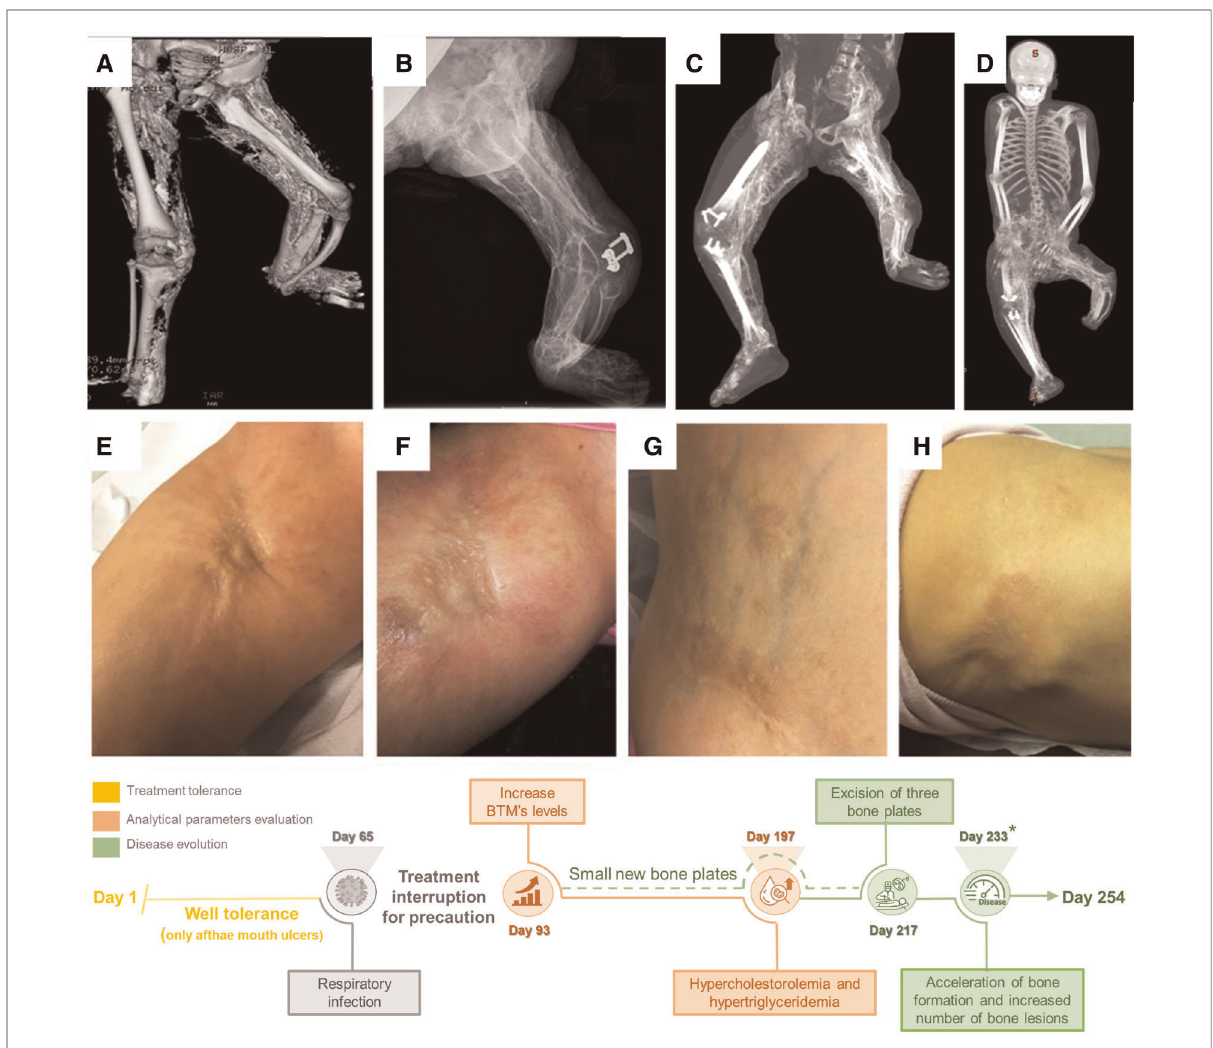
FIGURE 1 Clinical evolution of the patient with severe POH form and timeline related to Everolimus treatment (bottom). ( A – D ) Tridimensional body TC of Twin#1, showing the evolution of the disease in a 4-year period; ( E, F ) Disease progression before and after aggravation occurring around day 233* in the right groin; ( G – H ): New ectopic calci fi cations in the abdomen and left